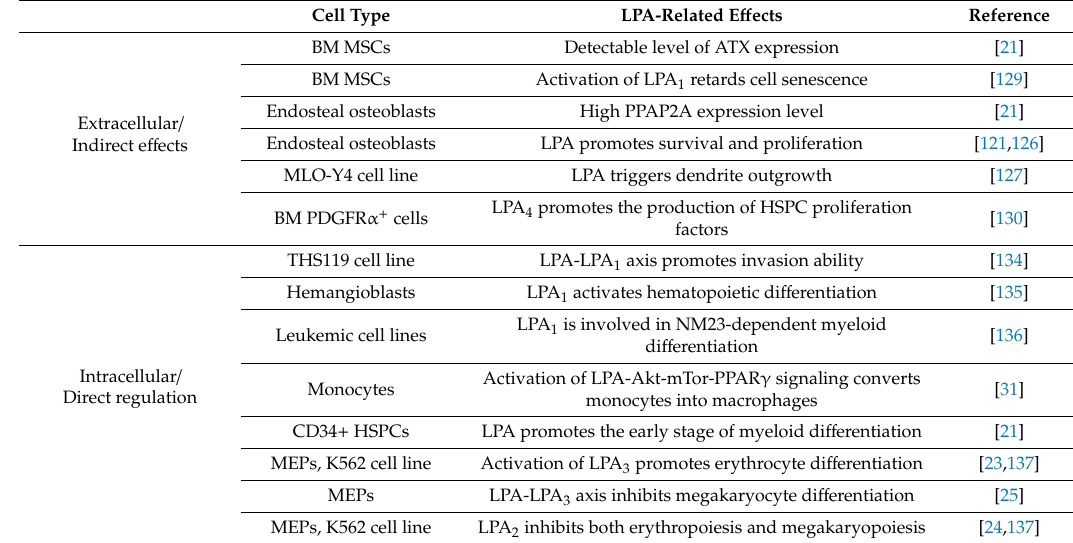
Table 1. Microenvironmental and intracellular e ff ects of LPA-LPAR axis during hematopoiesis. BM MSCs: bone marrow mesenchymal stem cells; HSPC: hematopoietic stem and progenitor cells; MEPs: megakaryocyte-erythroid